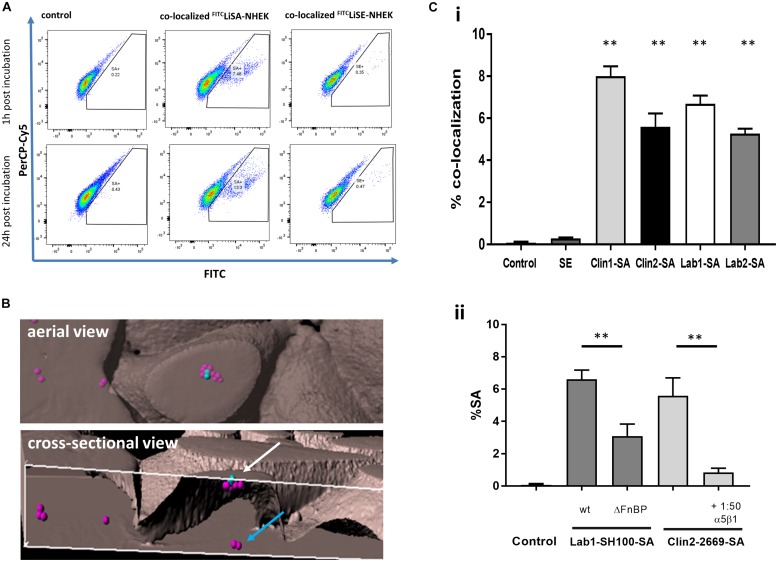
Internalization of live S. aureus but not live SE into primary Normal Human Epidermal Keratinocytes (NHEK) via α5β1-integrin. (A) NHEK were co-cultured with FITC-labeled live S. aureus (FITCLiSA) or SE (FITCLiSE) at 37°C for 1 h, followed by washing with penicillin/streptomycin to kill extracellular bacteria. Culture was continued for 1 or 24 h and co-localization determined by flow cytometry. Autofluorescence is shown on PerCp-Cy5/FITC double positive population. Controls represent NHEK without bacterial co-culture. Flow cytometry scatter plots and images are representative of three independent experiments with technical triplicates. (B) Internalization of GFPS. aureus by NHEK was confirmed by 3D confocal microscopy of NHEK after co-culture with 107 CFU/ml GFPS. aureus for 1 h at 37°C. Representative aerial and cross-sectional views of extracellular (blue spots) and intracellular (pink spots) S. aureus. (Ci) FITC-labeled clinical (Clin1-SA and Clin2-SA-NCTC2669) and laboratory (Lab1-SA-SH1000 and Lab2-SA-GFP) isolates of S. aureus were internalized to a similar extent by NHEK. (Cii) Fibronectin binding protein S. aureus mutants were less effectively internalized than the wild-type Lab1-SA-SH1000. Internalization of FITC-labeled Clin2-SA-NCTC2669 was inhibited with blocking anti-α5β1-integrin antibody. All experiments were performed in triplicate. Statistical comparison in comparison to WT was performed by one-way ANOVA. ∗∗p < 0.0001.